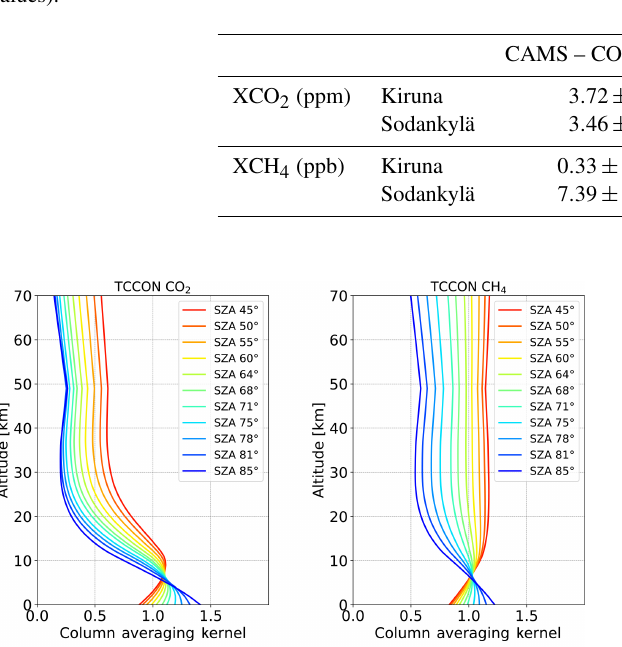
Table 1. A summary of statistics between two paired datasets is listed in terms of averaged bias and standard deviation (in brackets: R 2 values).